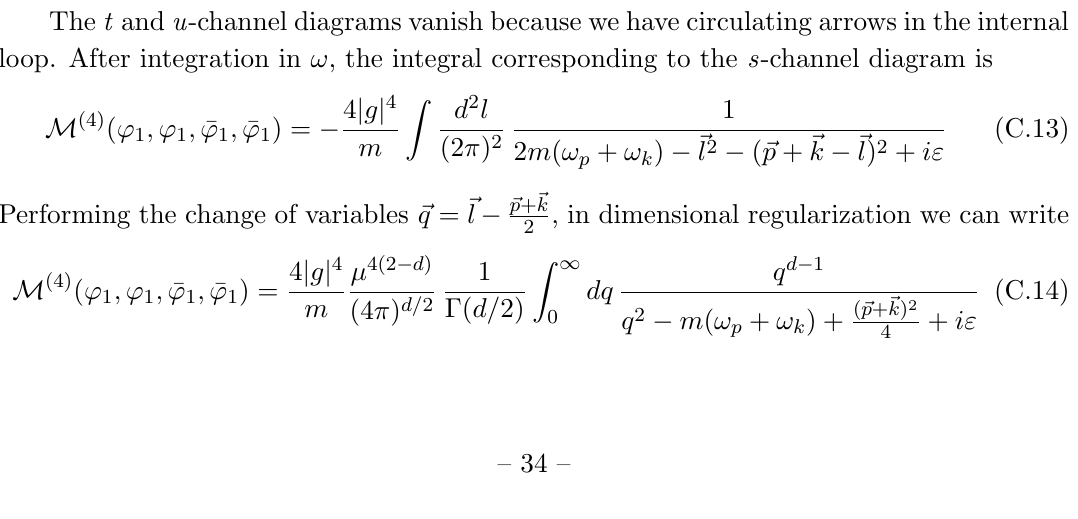
JHEP06(2019)048